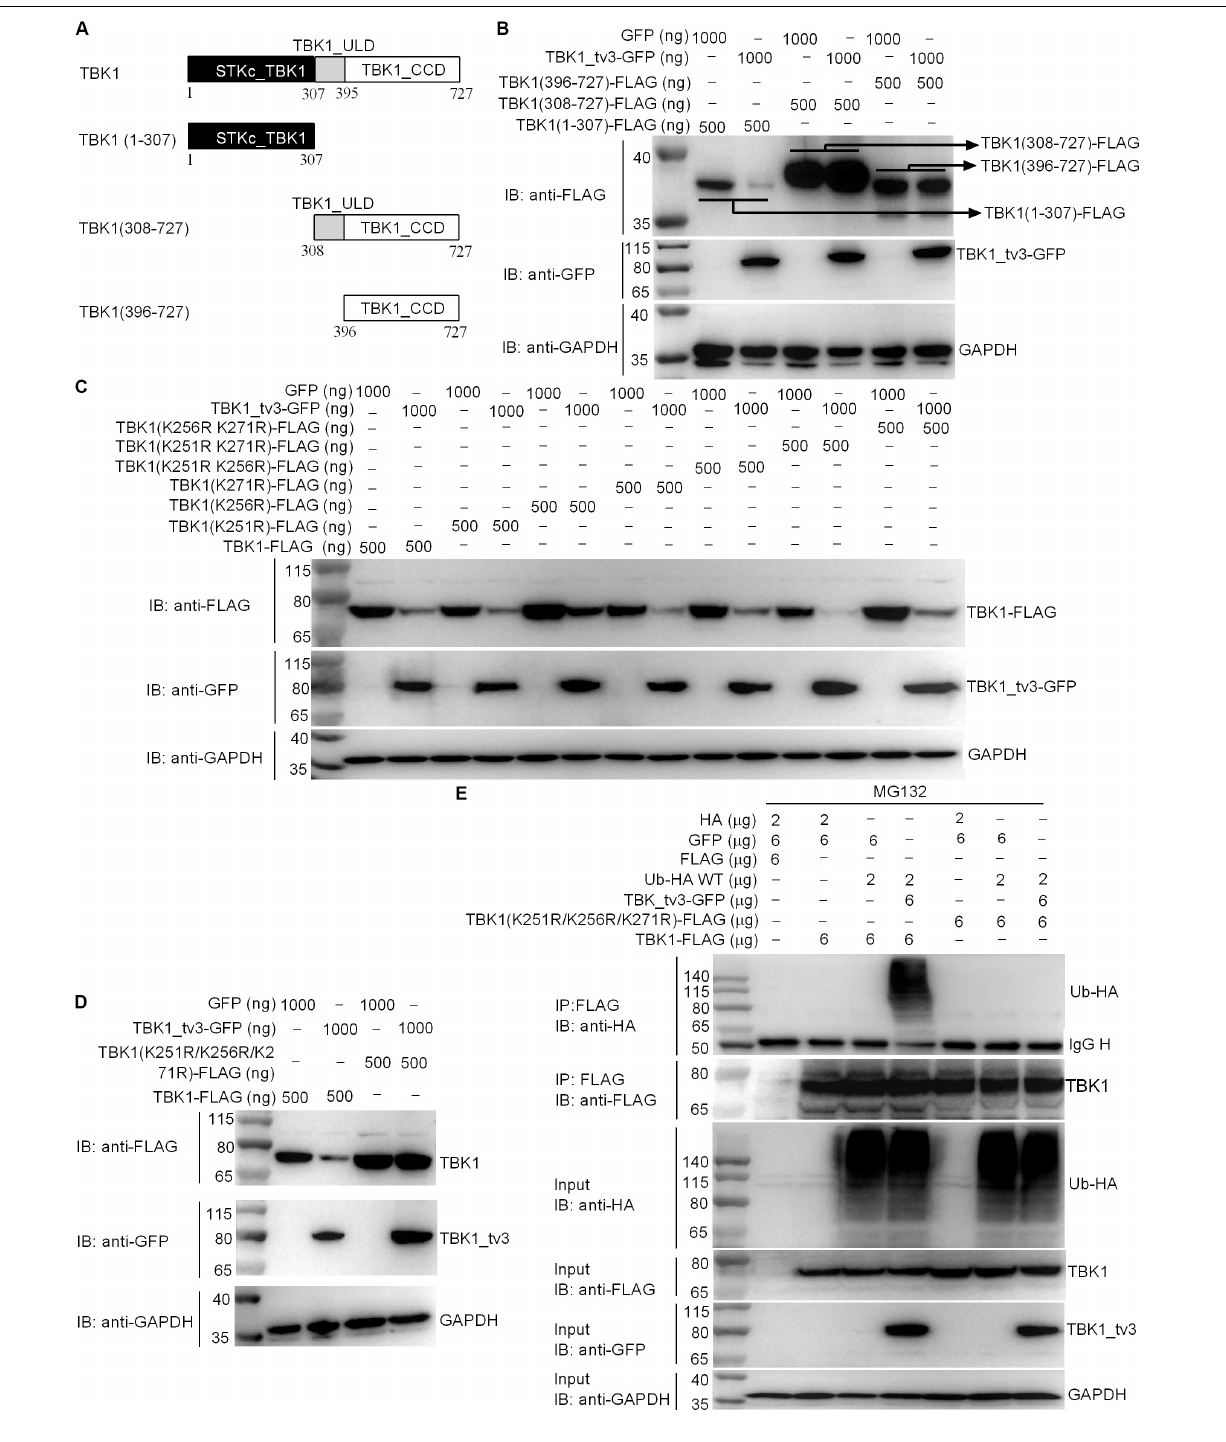
Frontiers in Immunology |